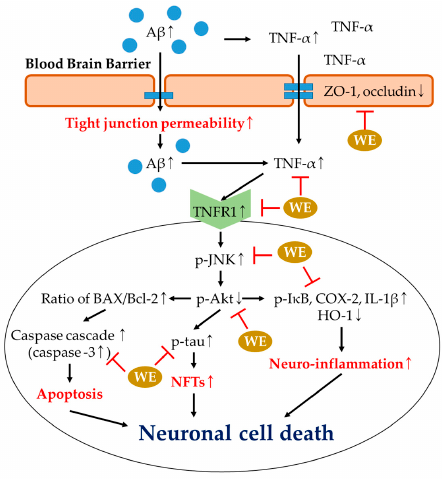
institute of cancer research (ICR) mice via regulation of the blood–brain barrier (BBB) function and neuro-inflammatory